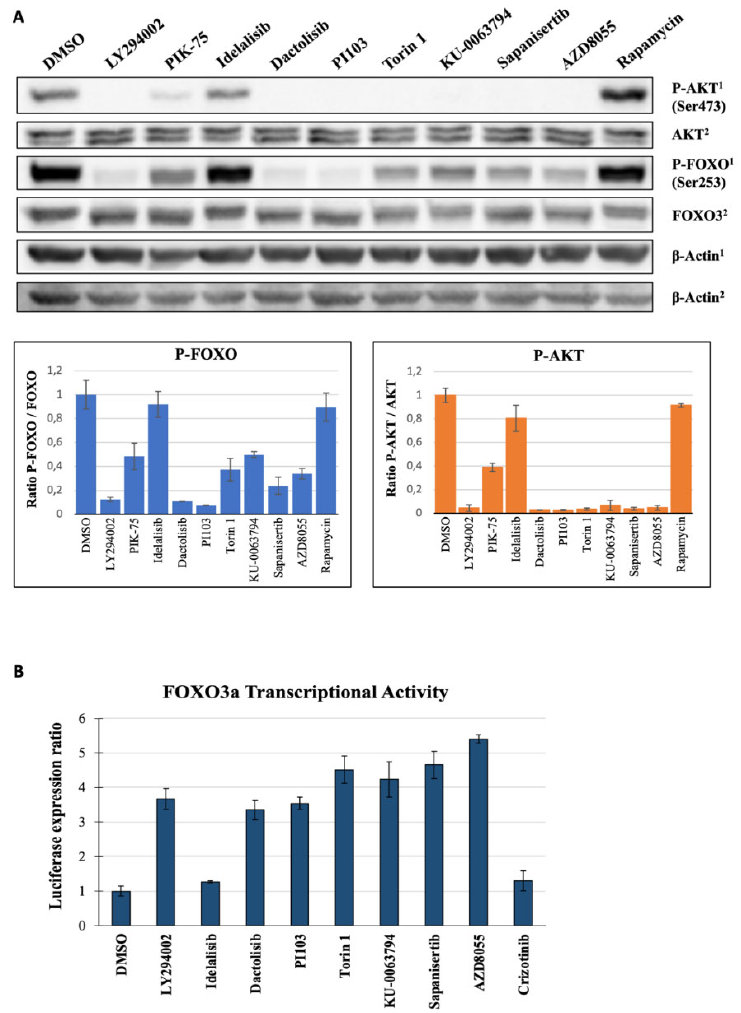
Figure 5. Inhibition of PI3K and mTOR affect FOXO and AKT phosphorylation and drive FOXO- dependent transcriptional activity. ( A ) U2foxRELOC cells were cultured and treated for 1 h with 1% DMSO (negative control), LY294002 25 µ M (positive control) or small molecule compounds (PIK-75, idelalisib, dactolisib, PI103, torin 1, KU-0063794, sapanisertib, AZD8055, crizotinib and rapamycin) at a final concentration of 1 µ M, and then were immunoblotted with specific antibodies against P-FOXO3 (Ser253) and total FOXO3, P-AKT (Ser473) and total AKT, and β -actin as the loading control. P-AKT and P-FOXO are labelled with 1 and should be compared with the loading control form the same membrane labelled as β -Actin 1 , while β -Actin 2 represents the control for total AKT and FOXO3. Blots represent the quantification of P ‐ FOXO3 and P ‐ AKT normalized by the correspondent